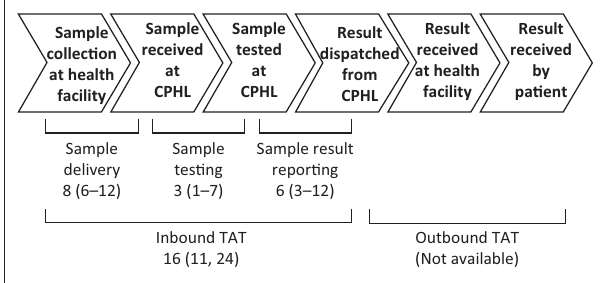
Puncher printer